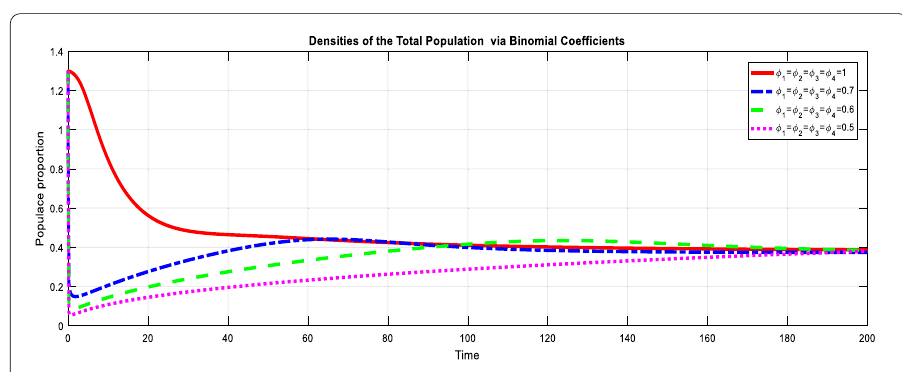
Figure 25 Dynamic of N ( t ) by varying the value of φ